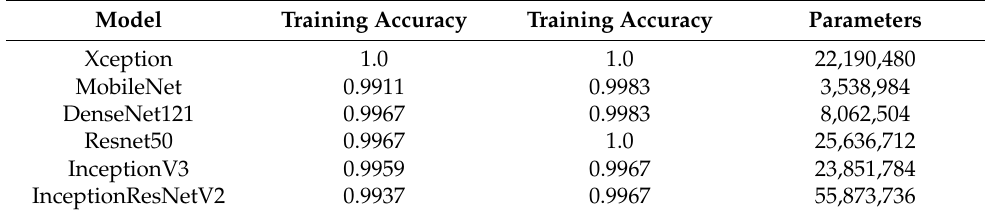
Table 8. The recognition accuracies of DCNNs applied on SF